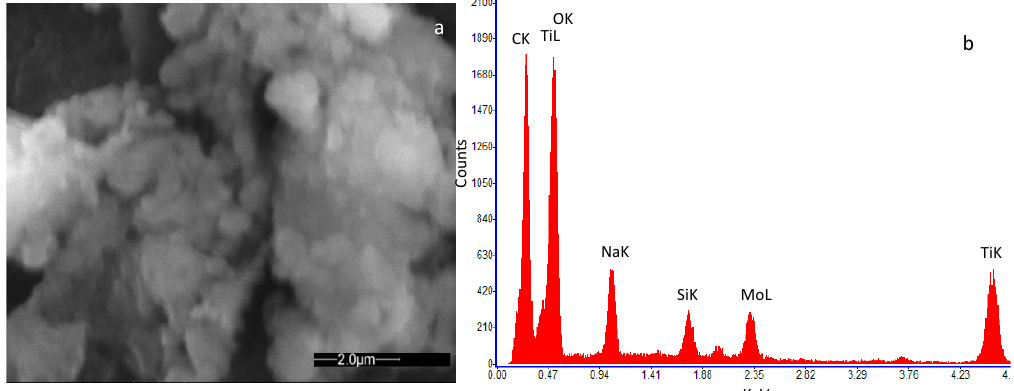
Figure 3. High-resolution field emission scanning electron microscopy (SEM) image of the deposited film of SWCNTs decorated by TiO2 nanoparticles. The microscopic investigation was performed with a Quanta 400 (FEI) emission scanning electron microscope, operated at 20.0 kV. ( a ) view of the deposited film; ( b ) result of the Energy Dispersive Spectroscopy (EDS) on the analyzed sample. TEM images of the investigated nanostructures are presented in Figure 4. The decoration of TiO 2 and Au nanoparticles on the CNT sidewalls is visible in Figure 4a,b, respectively. The comparison with the image of a pure SWCNT sample (Figure 4c) confirms the presence of the Au and TiO 2 nanoparticles in the SWCNT network, realizing the sensor decoration.